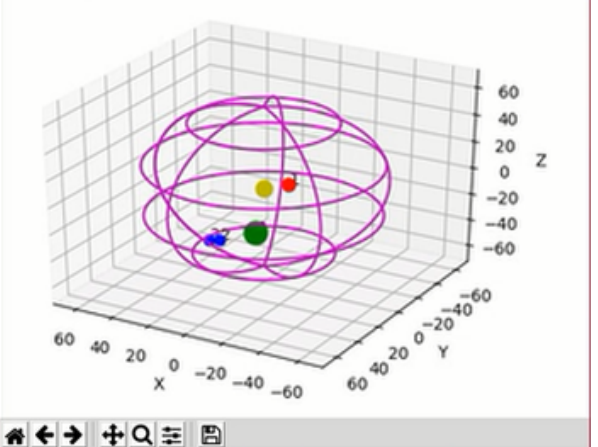
Figure 4. An example of an ego-spheric representation with simultaneous tactile (green circle), auditive (red circle) and visual (blue circle) stimuli.